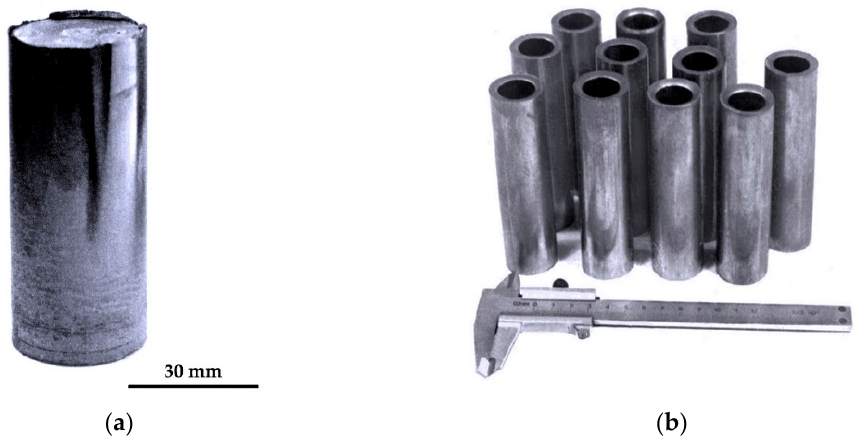
Figure 8. The casing of the surface of the sintered preform, obtained by the developed method: ( a ) Is a general view of the preform with the casing; ( b ) is manufactured parts from the obtained preform.